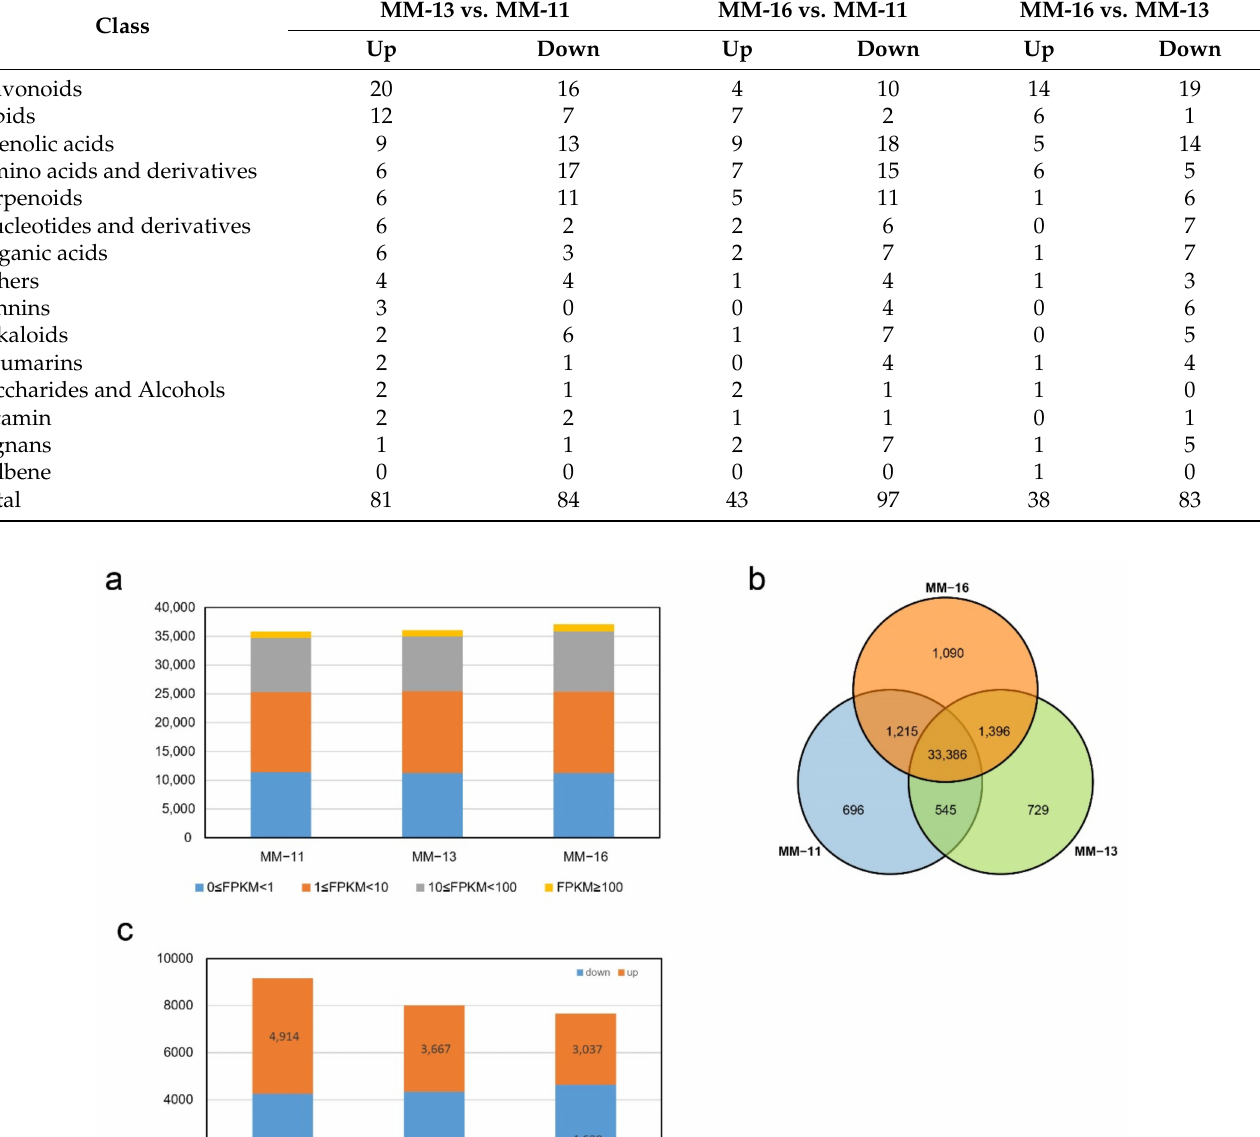
Table 1. Statistical analyses of differentially accumulated metabolites in MM-11, MM-13 and MM-16.